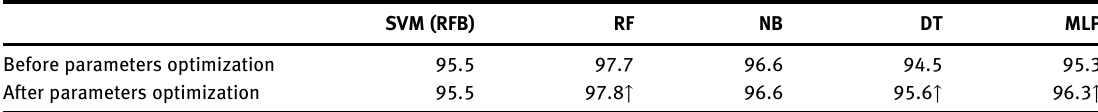
Table  : Summary of algorithm parameters optimization impact on the overall performance of the algorithms.